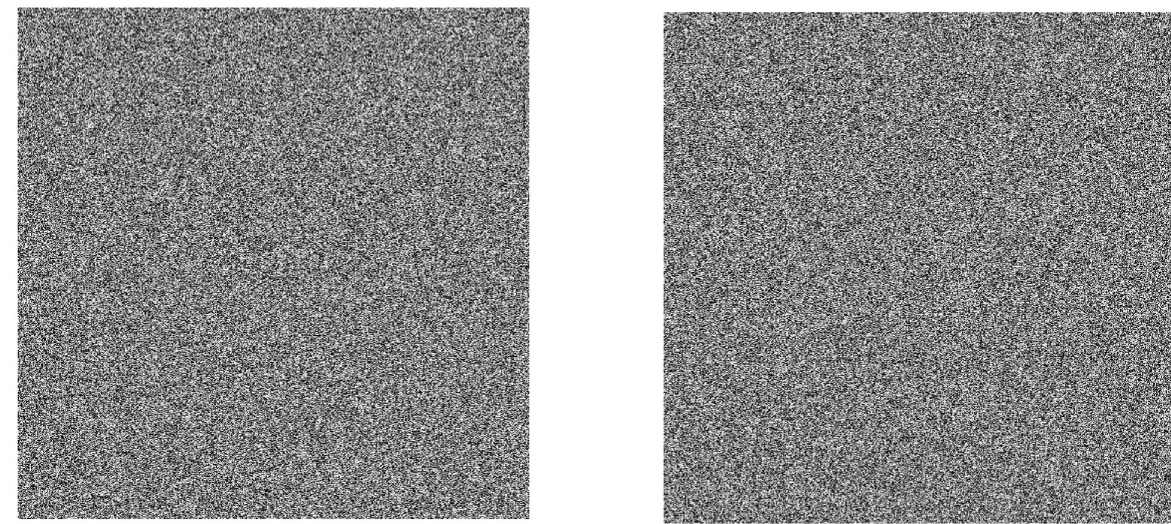
Fig 12. Encrypted and decrypted image after changing the key. (a) encrypted image, (b) decrypted image.